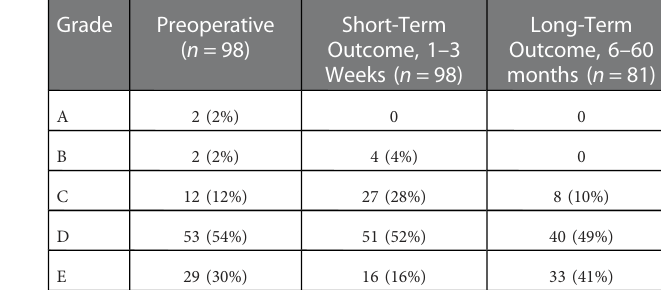
TABLE 3 Preoperative and postoperative neurologic Status according to